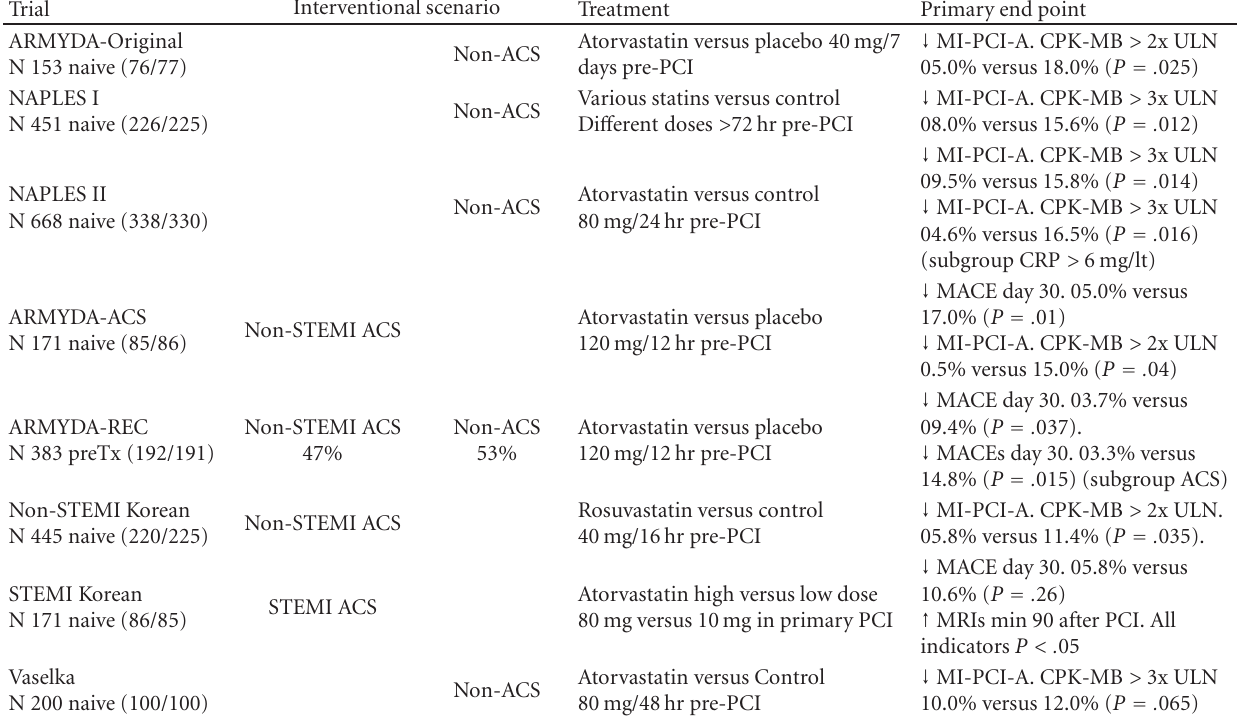
Table 1: Randomized trials with statins in percutaneous coronary intervention. This table is a summary of the 8 randomized trials (versus placebo or versus control groups) published with statins in individuals under PCI. All studies except Vaselka’s have shown positive results for the use of statins prior to PCI. The results in individuals with elevated CRP before PCI (NAPLES II) and in individuals with ACS (ARMYDA-ACS y ARMYDA-RECAPTURE, ACS soubgroup), are particularly favorable. MI-PCI-A: Myocardial Infarction-PCI associated. MACE: Mayor Adverse Cardiovascular Events. MRI: Myocardial Reperfusion